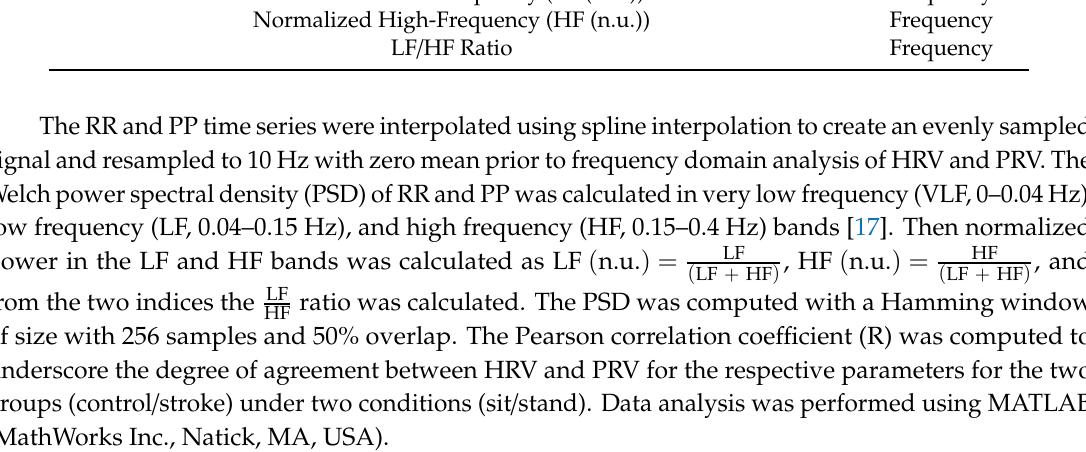
Table 1. Time and frequency domain metrics utilized in this research to compare the agreement between heart rate variability (HRV) and pulse rate variability (PRV). HRV / PRV Variables Domain Mean RR / PP intervals (heart period, HP) Time Standard deviation of RR / PP intervals (SDNN) Time Root mean square of successive di ff erence between adjacent intervals (RMSSD) Time Standard deviation of successive di ff erence between adjacent intervals (SDSD) Time Percentage of adjacent RR / PP intervals that di ff er by more than 50 ms (pNN50) Time Normalized Low-Frequency (LF (n.u.)) Frequency Normalized High-Frequency (HF (n.u.)) Frequency LF / HF Ratio